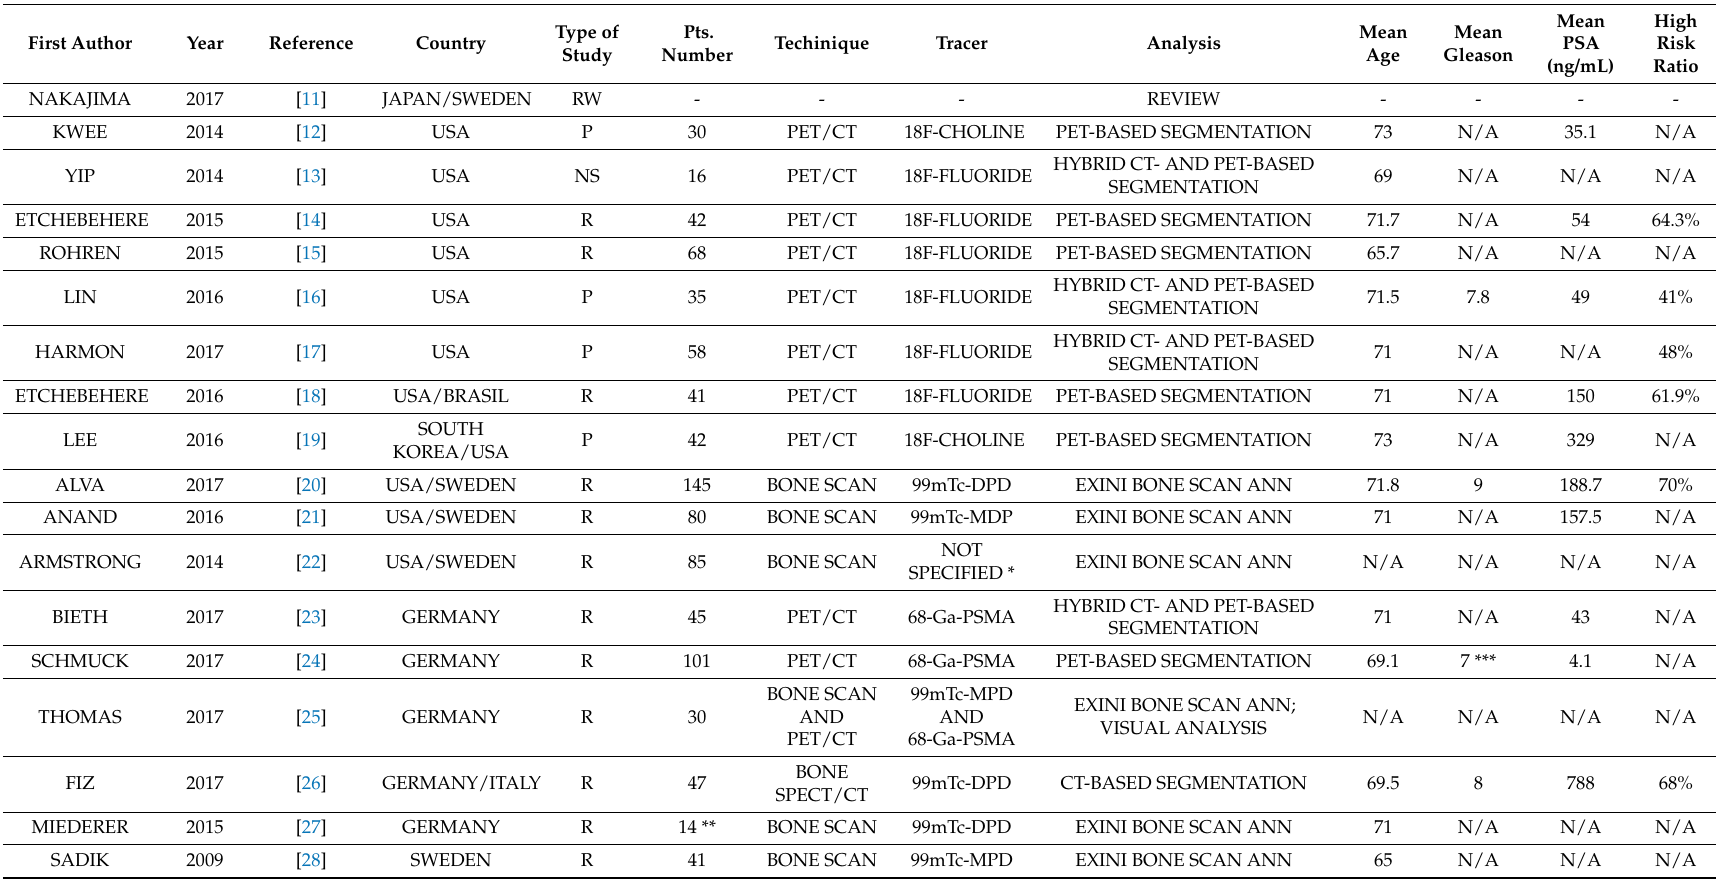
Table 1. Characteristics of the selected